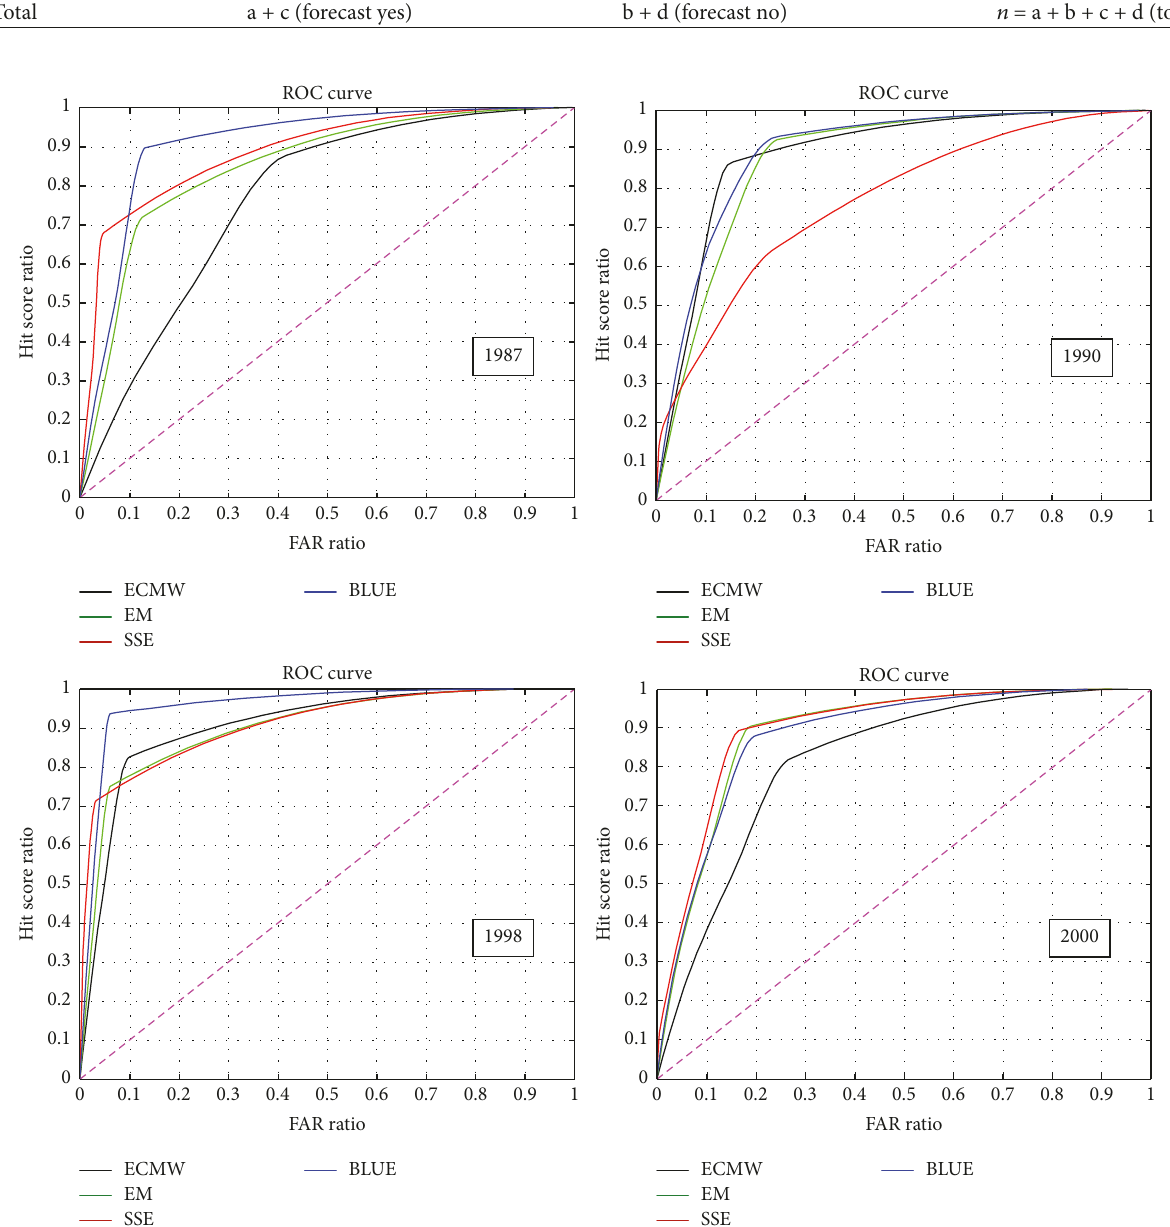
Figure 6: ROC plots for ECMWF, EM, superensemble scheme, and BLUE for JJAS seasonal rainfall anomaly predictions over Indian region.